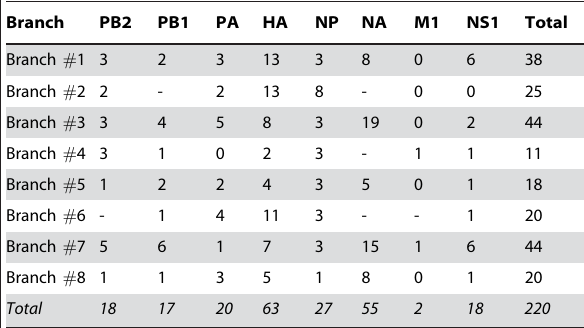
accession numbers refer to the PB2 gene. Clade letters and section numbers correspond to those given in Figure 1. All genome